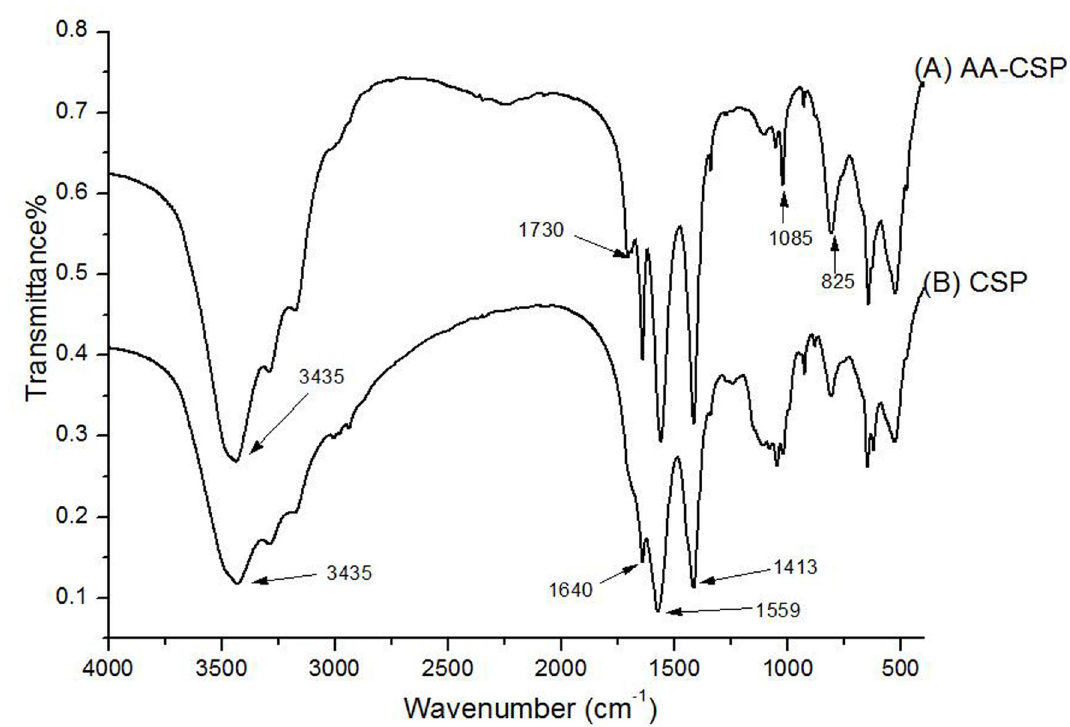
FIGURE 3 - Fourier transform infrared (FT-IR) spectra of AA-CSP (A) and CSP (B). FTIR experiments were recorded at 25 ° C on Shimadzu 8300 FTIR spectrometer with a KBr tablet with the range of 400 - 4000 cm -1 .